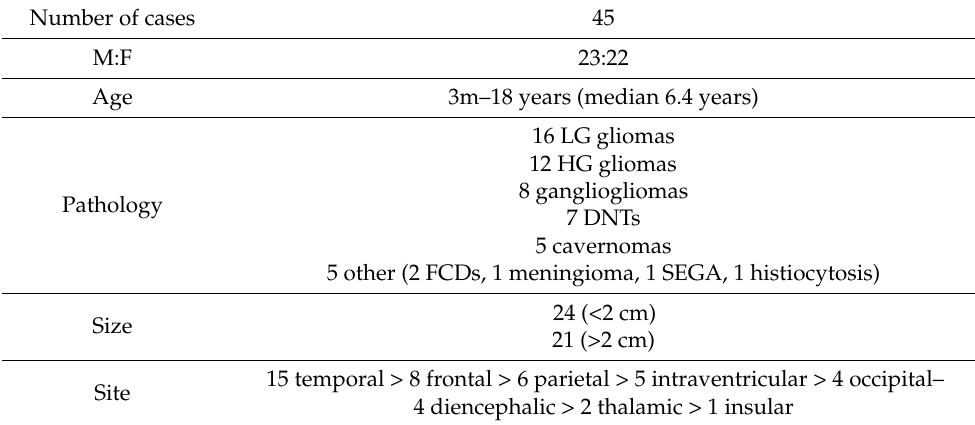
Table 1. Demographic and clinical